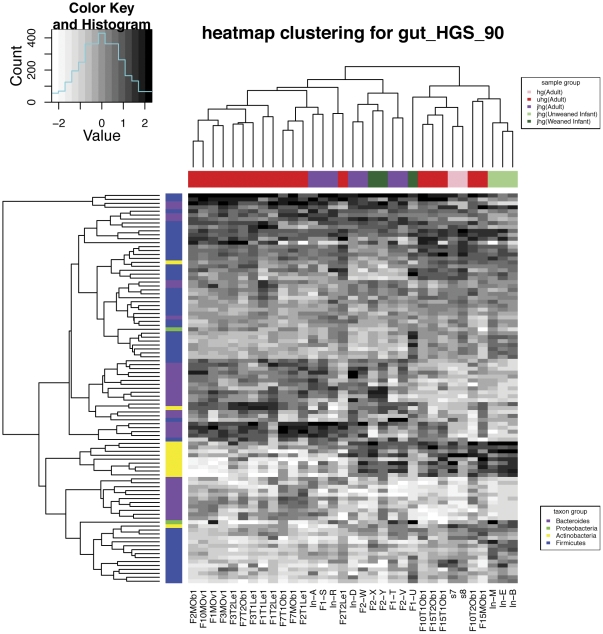
Heatmap biclustering of human gut metagenomes.‘gut_HGS_90’ indicates that the human gut (‘gut’) read sets were mapped to the reference genome set (‘HGS’) with an identity rate cut-off at 90% (‘90’). The bottom labels indicate human gut samples. The top right legend shows the color-coding for columns indicating the sample age category and dataset origin. The bottom right legend shows color-coding for rows indicating the top 4 most abundant phyla in human gut. The relative abundance for each sample is normalized by a rank transformation.